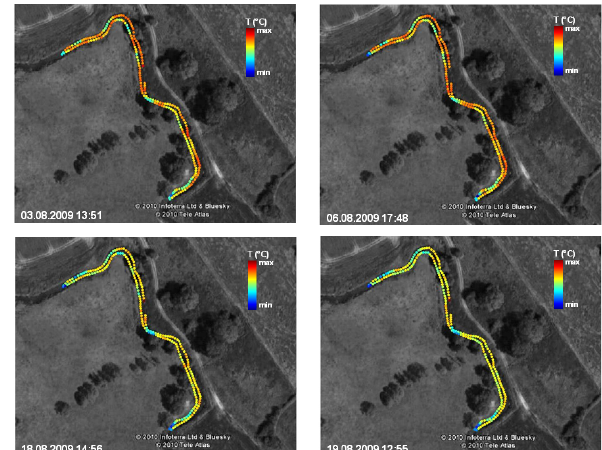
Fig. 7. Spatial patterns streambed temperature anomalies measured with FO-DTS on 4 representative sampling dates in August 2009. The colour scheme covers a range of 3 ◦ C for all 4 maps (absolute temperatures varied slightly from one sampling date to the